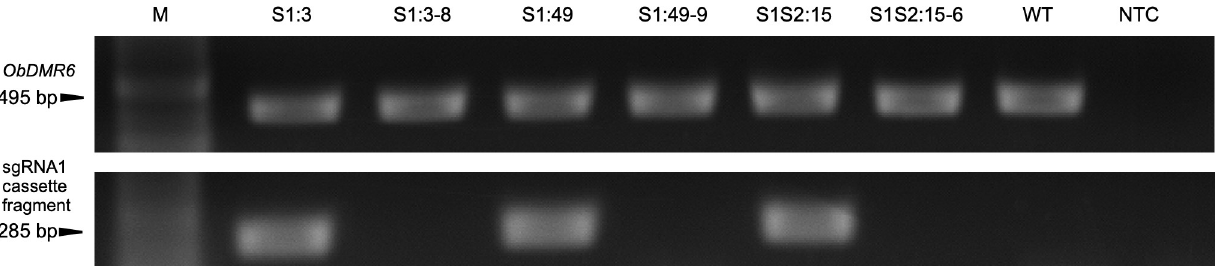
Fig 4. Characterization of transgene-free T1 plants expressing sgRNA1 only (S1) and two sgRNAs (S1S2). Agarose gel images showing PCR amplification of a 495 bp ObDMR6 fragment (upper panel) and part of sgRNA1 cassette (lower panel) using primers shown in Fig 2. T1 plants S1:3–8, S1:49–9 and S1S2:15–6 were derived from T0 lines S1:3, S1:49 and S1S2:15, respectively. WT, wild-type plant; NTC, no template control; M, NEB 100 bp ladder.